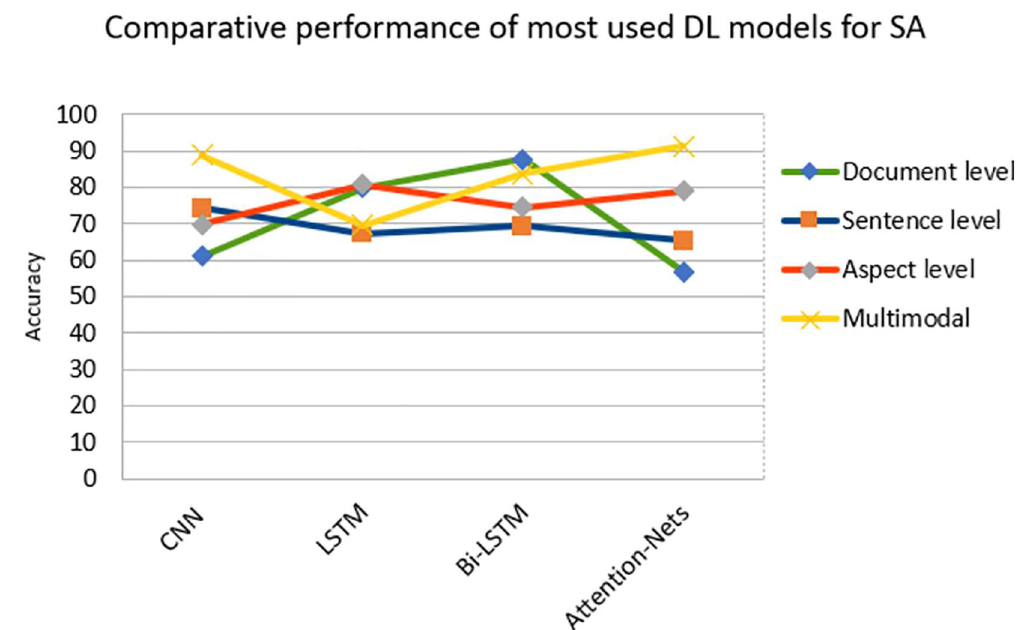
Fig 11. Most used DL models in SA and their